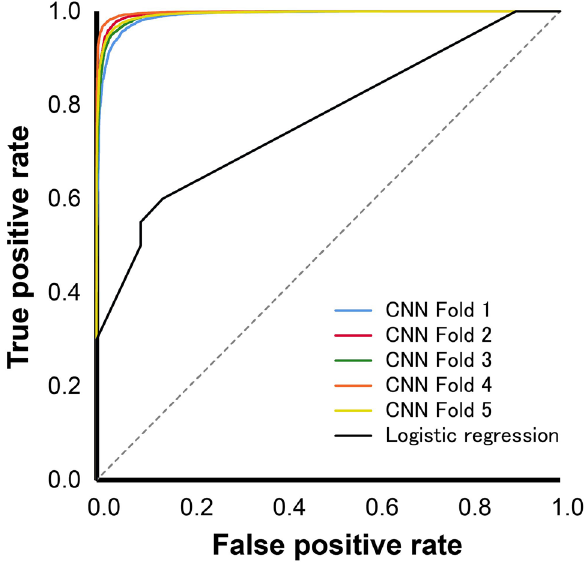
Figure 2. The receiver operating characteristics curves of logistic regression analysis and the DL model. ROC curves show the performance of logistic regression analysis and the ResNet model in the validation dataset in detecting early recurrence. The AUC of logistic regression analysis is 0.770, and the average AUC of the convolutional neural network (CNN) model is 0.994.